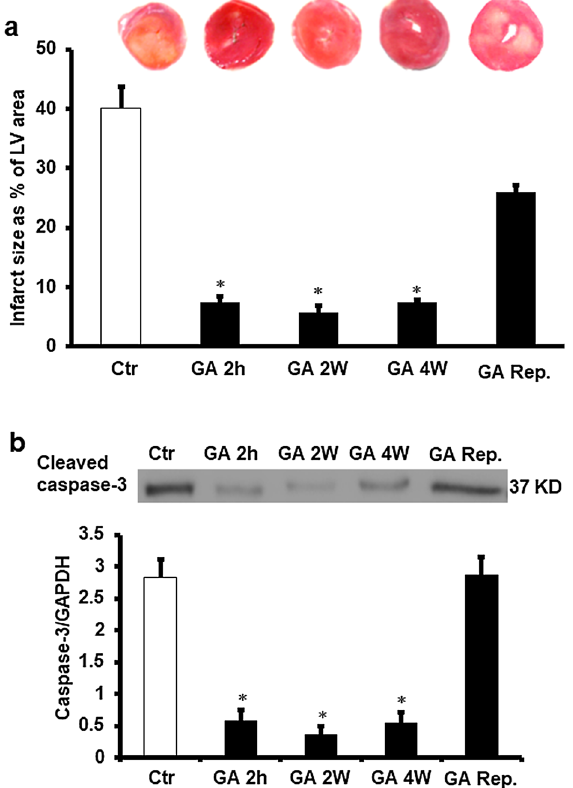
Figure 3. Evaluatin of infarct size and apoptosis markers. ( a ) Infarct size after GA treatment (n = 4). Top: representative 2,3,5-triphenyl-2H-tetrazolium chloride-stained heart slices for each treatment condition. Bottom: measured infarct size, normalized to the LV area, in isolated rat hearts at the end of reperfusion. ( b ) Cleaved caspase-3 protein levels after GA treatment (n = 4). Top: Western blot showing casepase-3 protein levels corrected to GAPDH. Bottom: Cleaved caspase-3 protein levels corrected to GAPDH. Ctr control, Rep reperfusion, GA 2 h Gum Arabic infusion 2 h before sacrifice, GA 2 W Gum Arabic administration for 2 weeks,